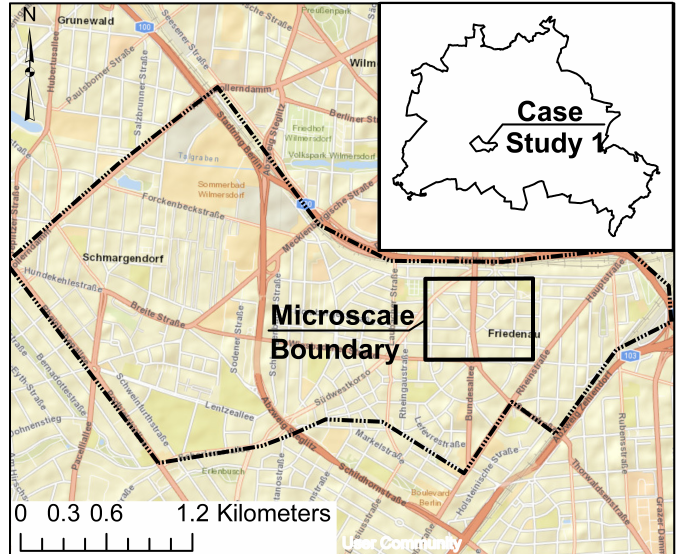
Figure 5. The spatial extent for the mesoscale and